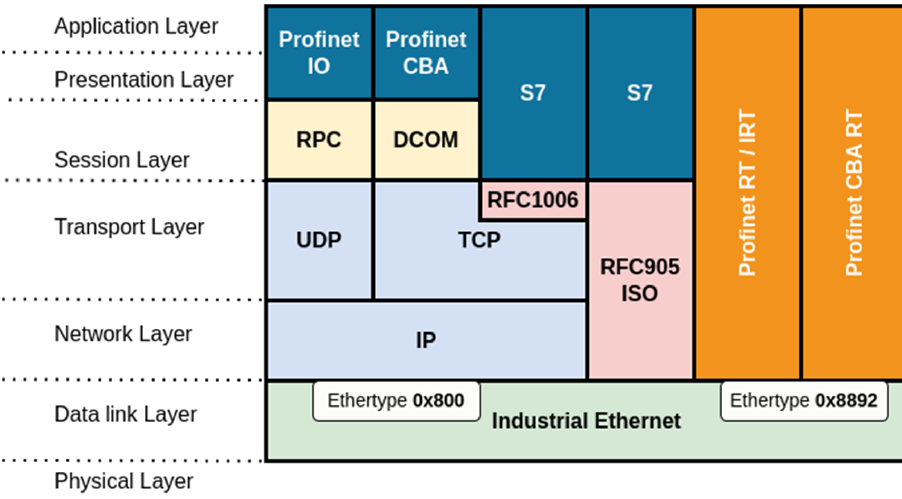
Figure 4. Collection of protocols within Profinet according to RM OSI.